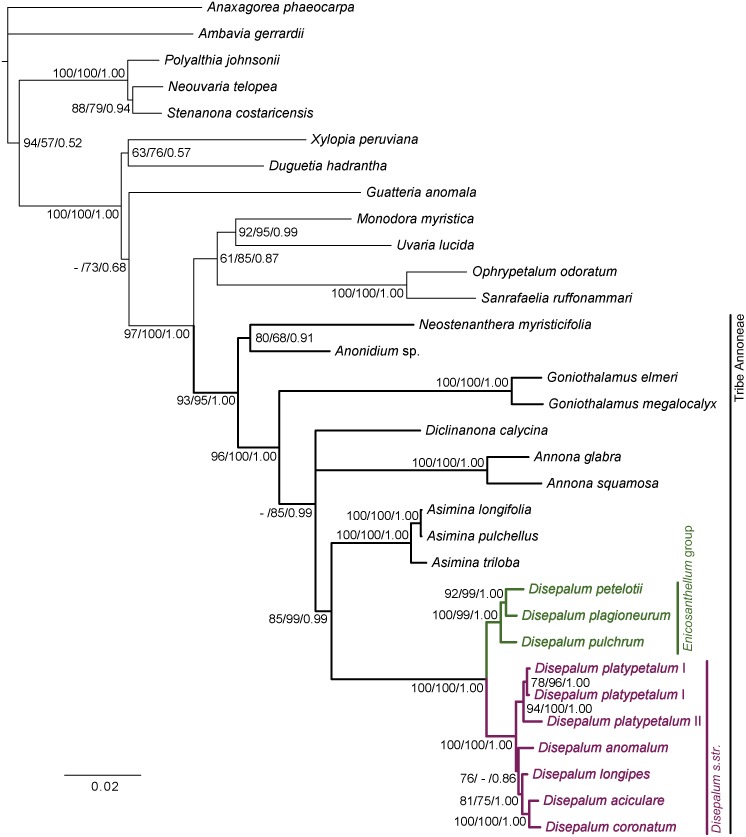
Bayesian 50% majority-rule consensus tree under partitioned model based on combined cpDNA (matK, trnL-F, ndhF and ycf1) and nDNA (AP3 and phyA) DNA sequence data.Numbers at nodes indicate MP, ML bootstrap values (> 50%) and Bayesian posterior probabilities (> 95%). Bootstrap values < 50% are indicated by ‘-’. Scale bar: 0.02 substitutions per site.